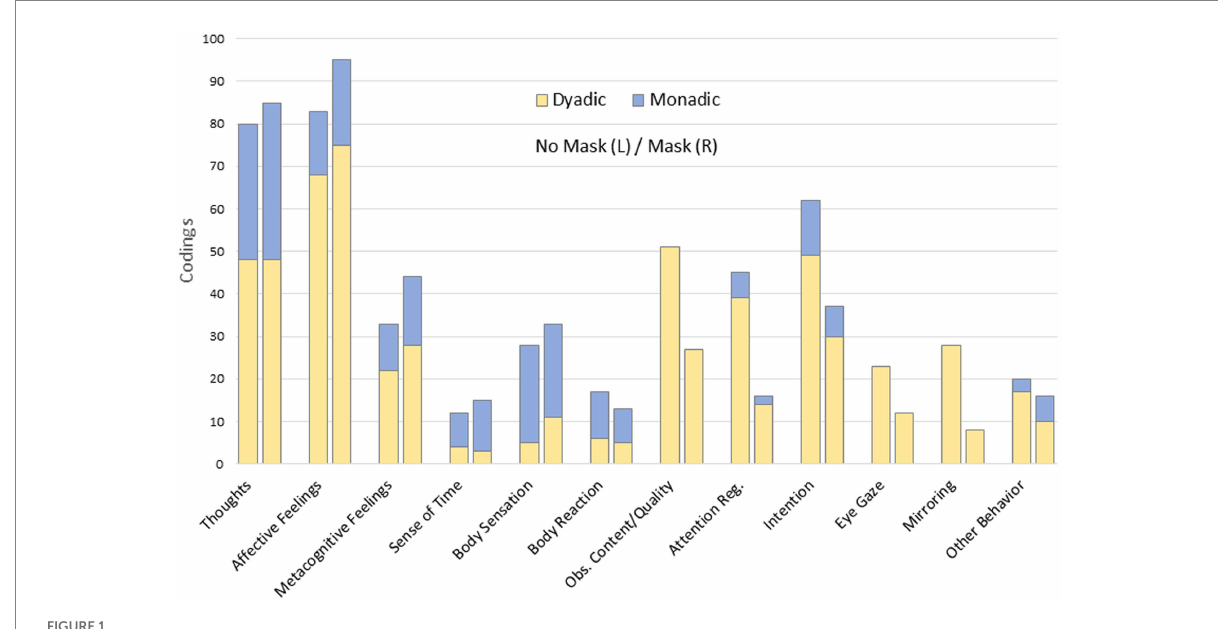
FIGURE 1 Code relations between levels 1 and